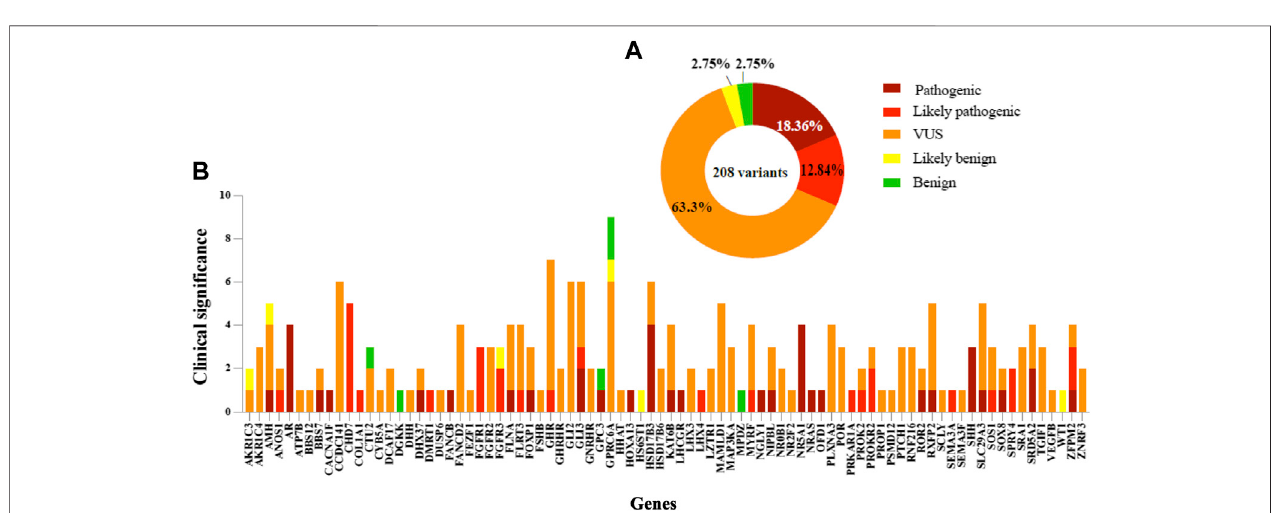
FIGURE 3 | Distribution and classi fi cation variants in DSD cohort. (A) Summary of 208 variants frequency found for each classi fi cation. (B) Variants in 84 genes in which the genetic cause was identi fi ed in syndromic/non-syndromic 46, XY DSD. The pathogenicity of variants is shown for each gene.